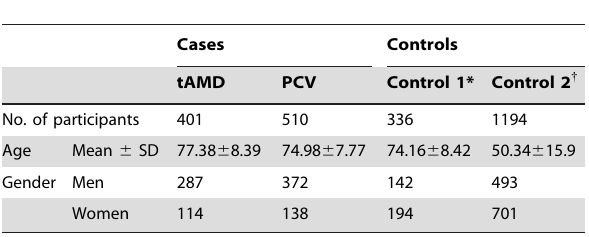
Table 1. Characteristics of the Study Population.